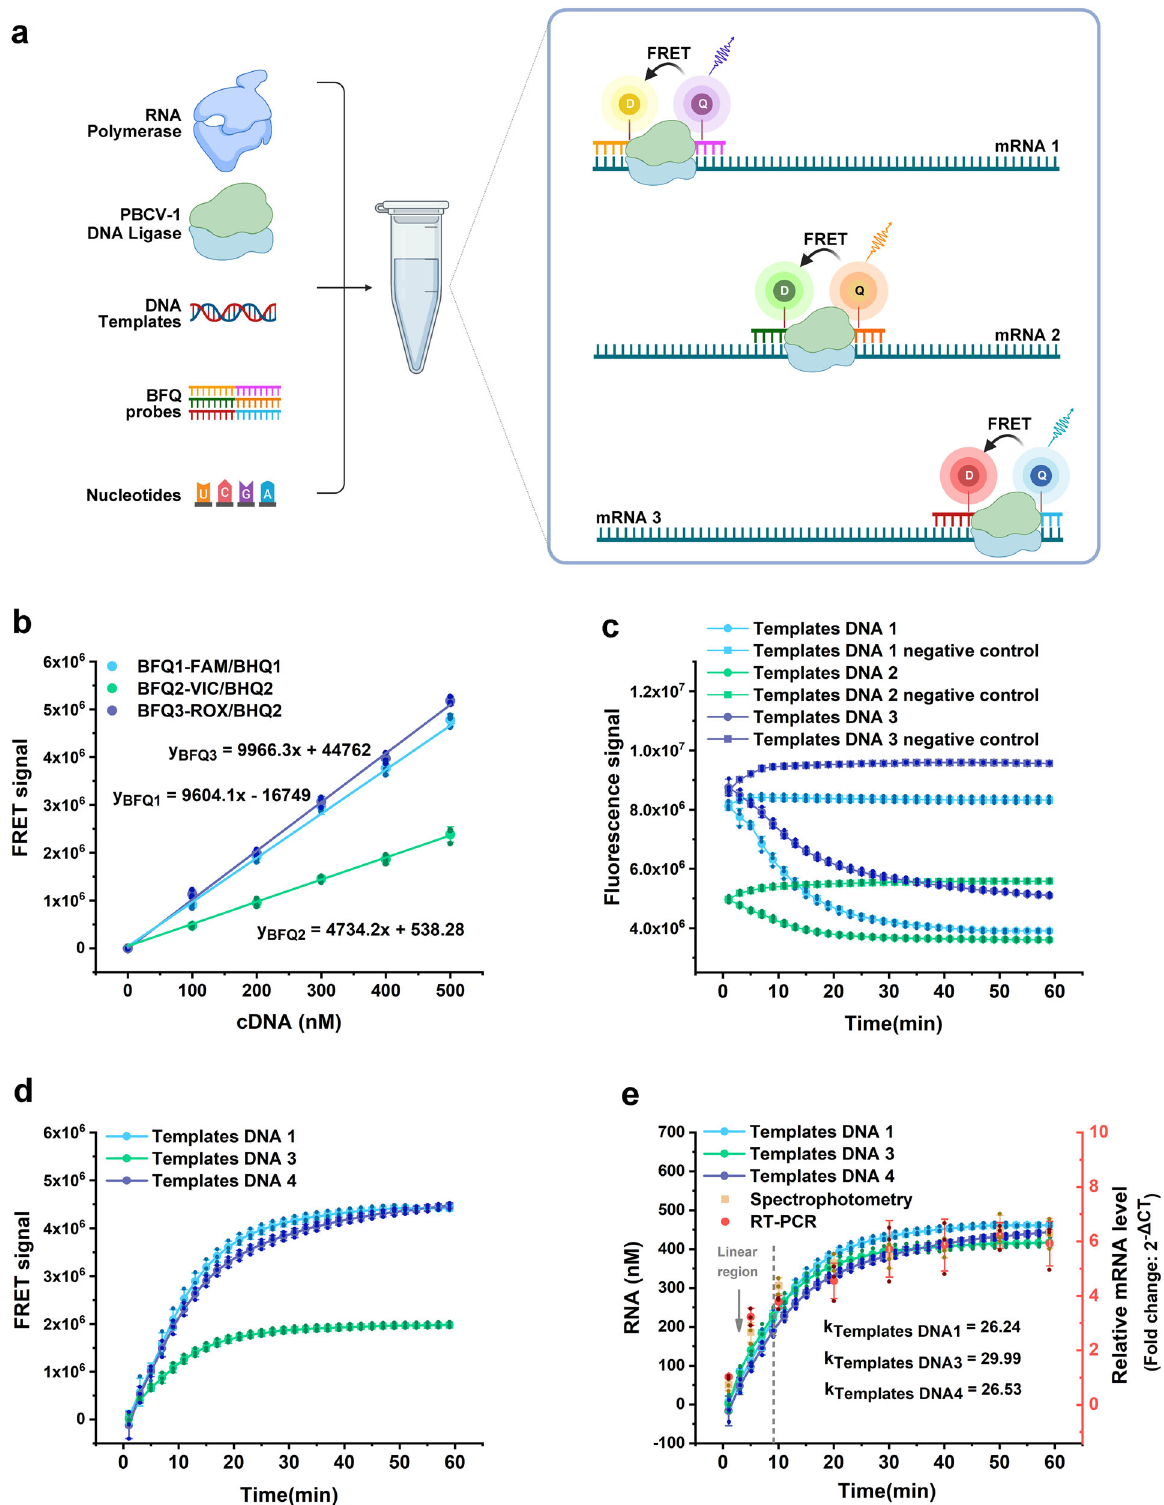
standard curves (Fig. 5b). During transcription, the three different DNA templates (DNA 1, DNA 2, and DNA 3), three different BFQ pairs (BFQ1, BFQ2, and BFQ3) with T7 RNAp, and PBCV-1 DNA ligase were mixed and then analyzed in the RT-PCR thermocycler at 37 °C by its FAM/VIC/ROX scan channels. Figure 5c, d show the raw data and the relative quantitative (the negative control signal data was corrected)